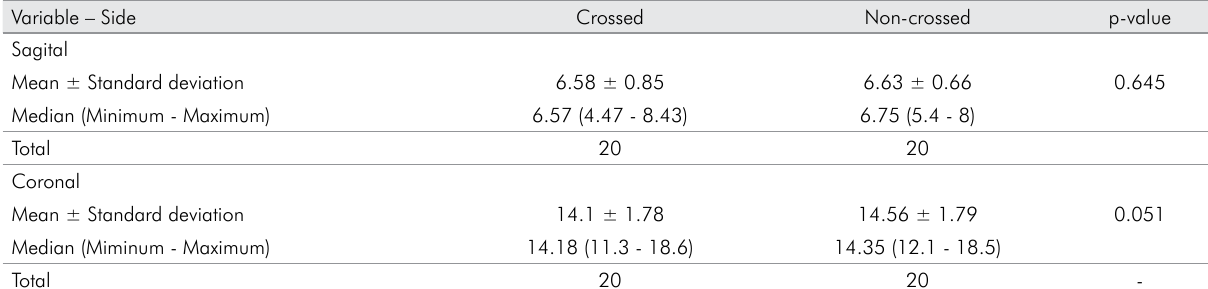
Table 2. Descriptive analysis, mandibular condyle between the crossed and non-crossed side, in the sagittal and coronal planes, and the result of parametric test t-Student